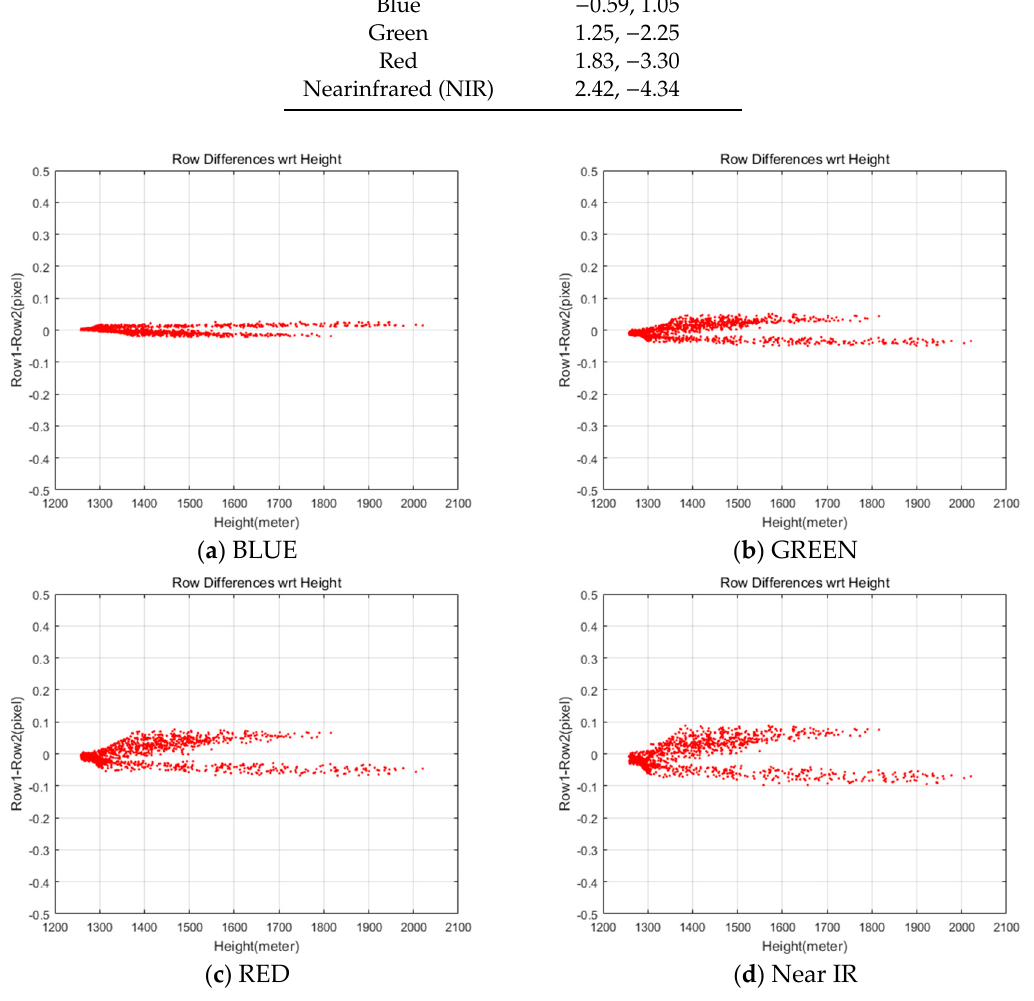
Figure 11. Differences in row coordinate between MS and PAN images after the terrain elevation Figure 11. Di ff erences in row coordinate between MS and PAN images after the terrain compensation. elevation